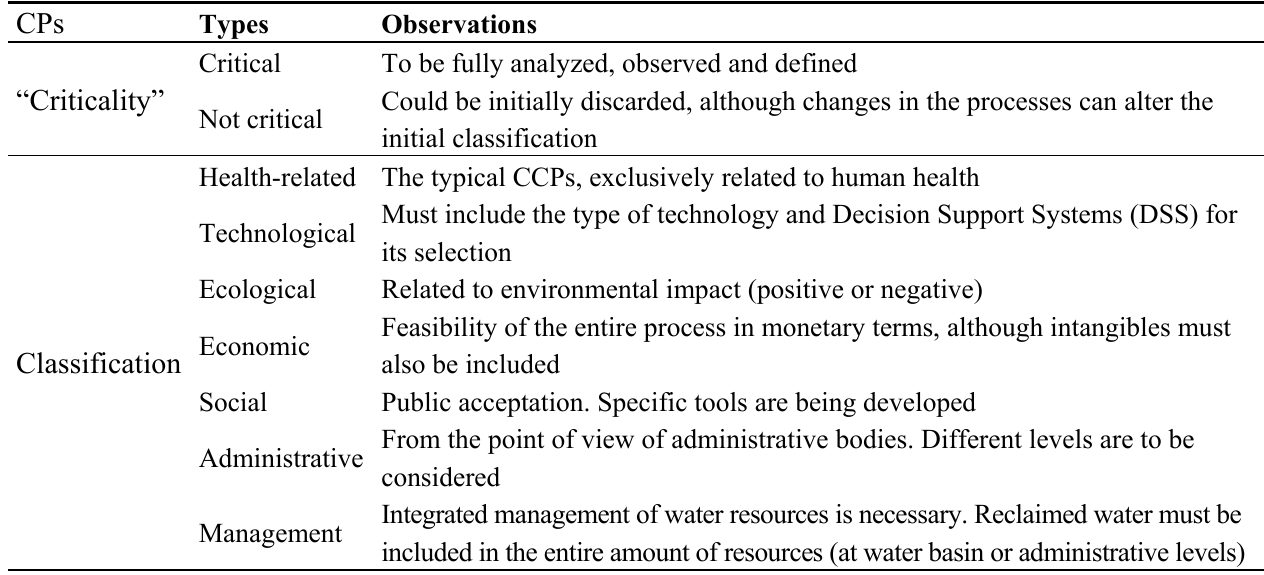
Table 17. Definition and types of Control Points